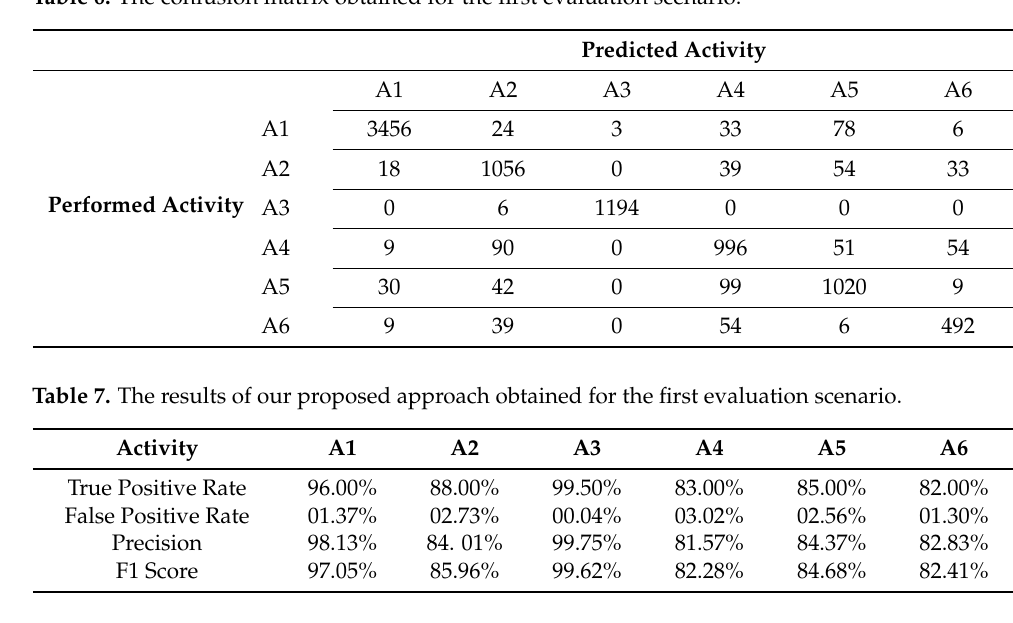
Table 6. The confusion matrix obtained for the first evaluation scenario.